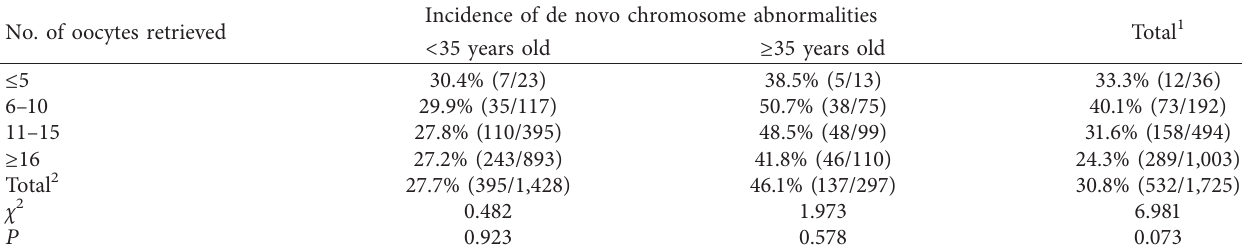
Table 3: Relationship between the incidence of de novo chromosome abnormalities and number of oocytes obtained.